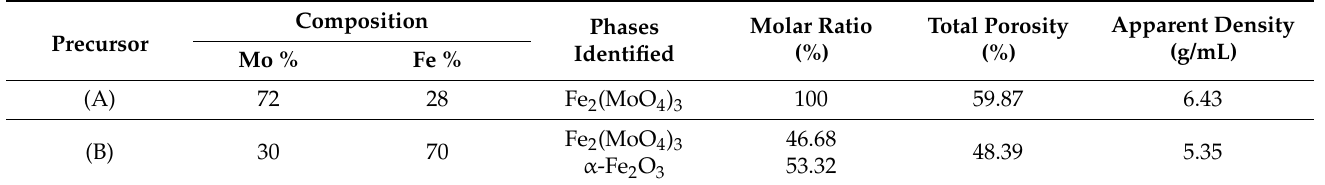
Table 1. Characteristics and phases identified in precursors roasted at 500 ◦ C for 3